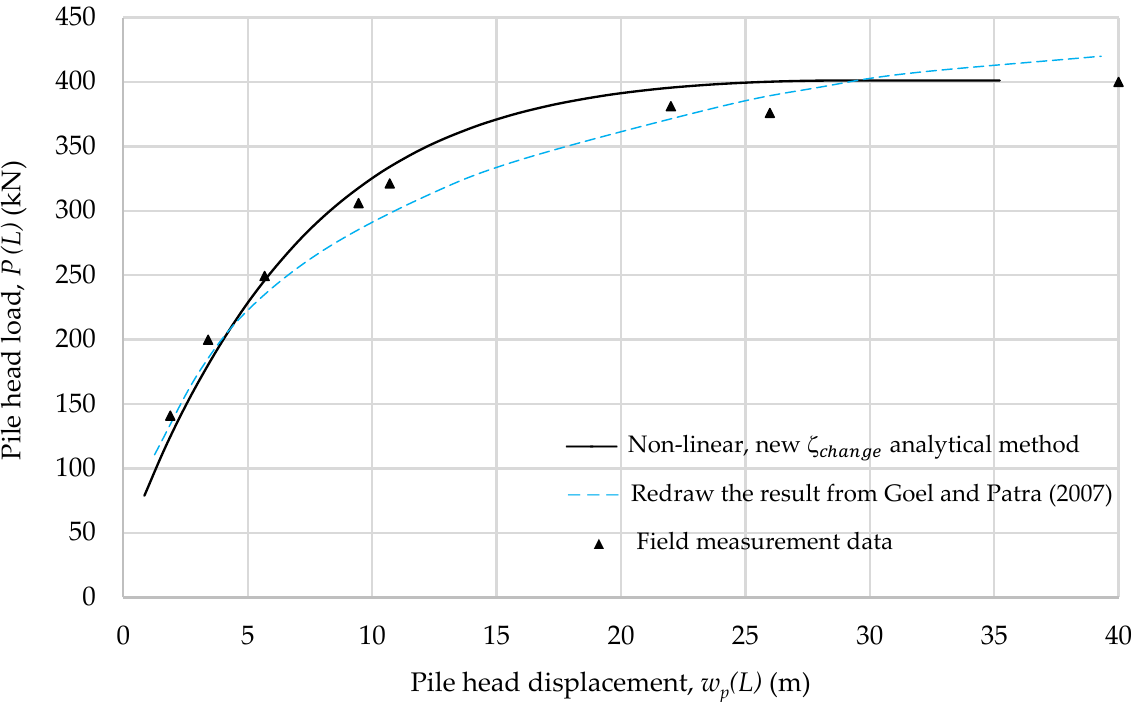
Figure 22. Load–displacement curve at the pile head in the case study P1 of Sowa [28].